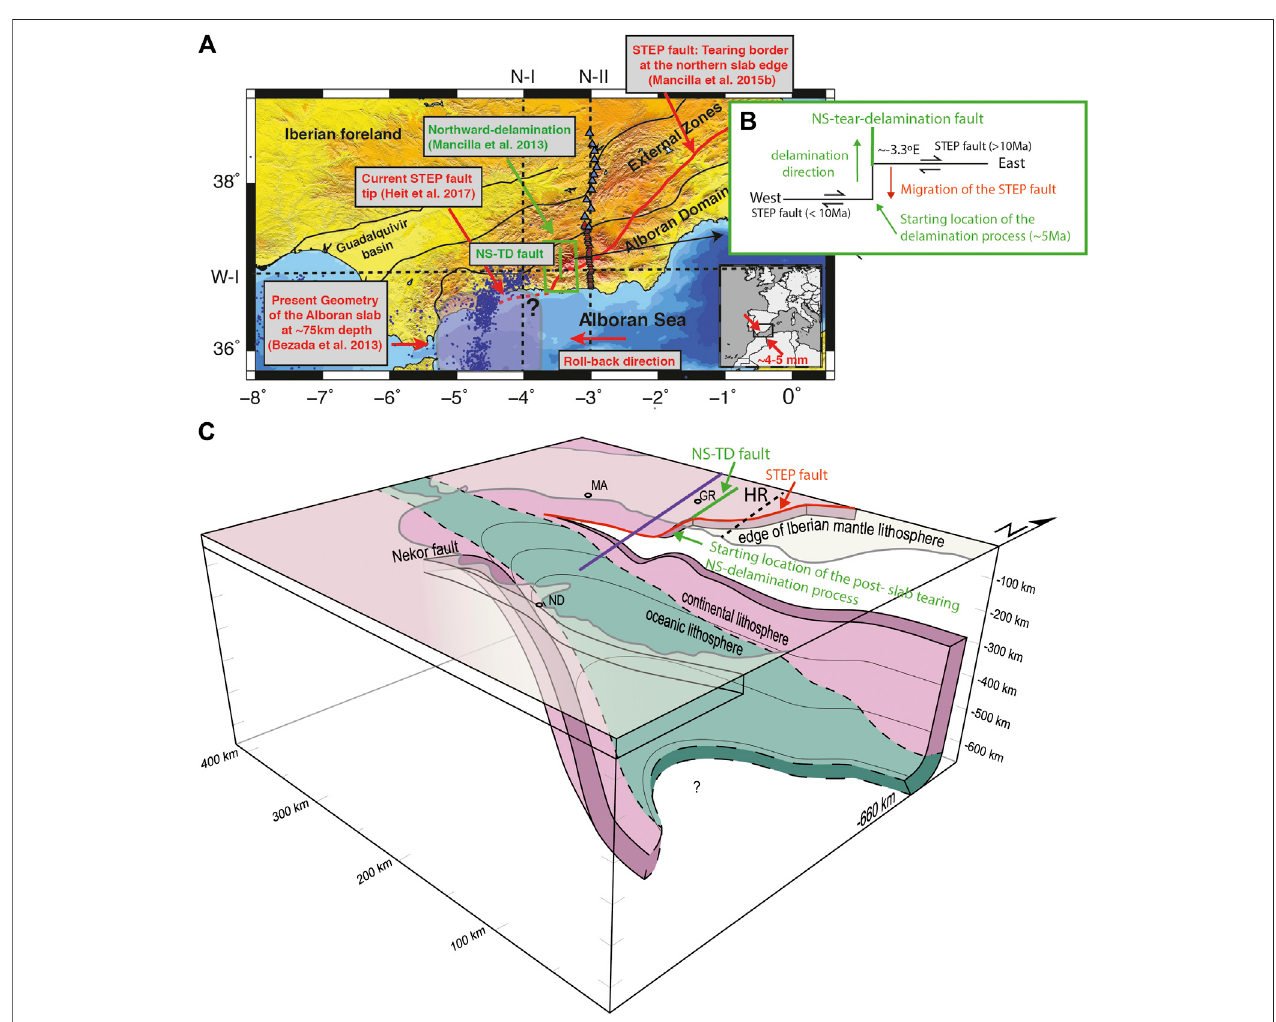
FIGURE 1 | (A) Topography map with the boundary of the main tectonic units of the Betic domain and foreland. The continuous red line marks the edge of the Iberian crust, i.e., the tearing border produced by a Subduction-Transform Edge Propagator (STEP) fault imaged by the P-receiver functions (Mancilla et al., 2015a) and thereddashedlineindicatesthepresumablycurrenttippositionofthisSTEPfault(Heitetal.,2017).Thegreensquaremarkstheareainvestigatedbythispaperasprone foradelaminationprocessesdirectedtowardthenorth,perpendiculartotheSTEPfault.Thepurpletransparentareadelimitsthepositivevelocityanomalyat75 km depthdescribedinthetomographystudyofBezadaetal.(2013)associatedwiththeoceanicAlboranslab.Redtrianglesarethelocationofthe fi rstlegoftheHireseismic pro fi le ( ∼ 2 km inter-station distance, HIRE-I), blue triangles the second leg ( ∼ 10 km inter-station distance, HIRE-II). Black dashed lines mark the locations of the P-wave receiver functions pro fi les of Figure 2 : N-I ( Figure 2A ); N-II ( Figure 2B ) and W-I ( Figure 2C ). The inset map shows the collision direction of the Iberia and Africa plates. (B) Sketch of the relationship between the NS-tear delamination fault (TD-fault, green line), that allows the northwards migration of the delamination process, and the STEP fault that facilitates the slab rollback motion toward the west of the western Mediterranean subduction system. (C) Sketch of the proposed geometry by Mancilla et al.(2015b), ofthe underthrusted Iberian and Maghrebian lithospheres and their relation with thesubducted oceanic slab observed by tomographic studies